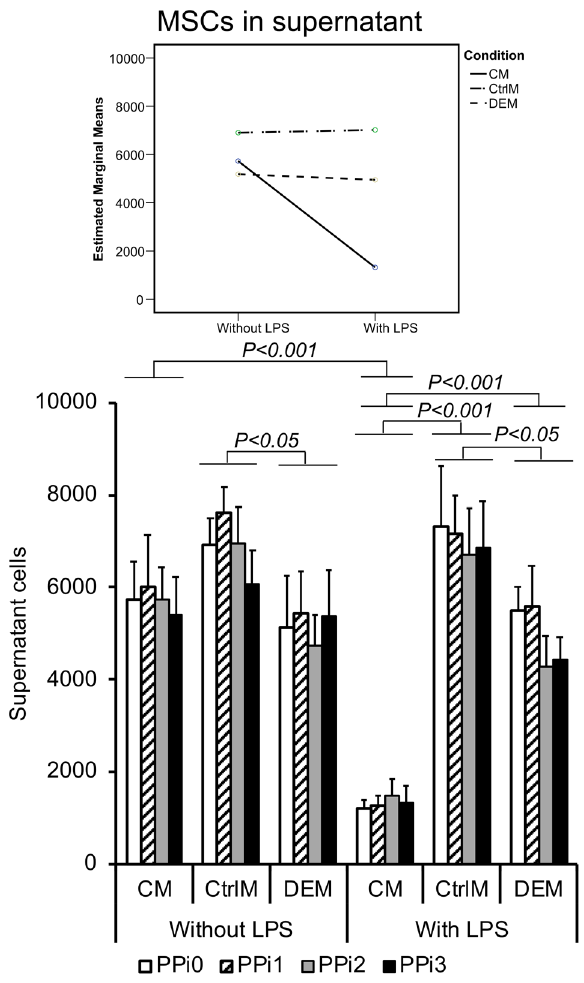
Fig. 3 Cell count of mesenchymal stem cells (MSCs). Number of MSCs in the supernatant after 72 h of culture in different culture media: CM = conditioned media from monocytes incubated for 48 h in polystyrene well plates in the presence or absence of lipopoly- saccharide (LPS) and exposed to different pyrophosphate (PPi) con- centrations; CtrlM = control media incubated for 48 h in polystyrene well plates in the presence or absence of LPS and exposed to different PPi concentrations; DEM = direct effect media incubated for 48 h in 50 mL tubes and used for direct exposure of MSCs to LPS and dif- ferent PPi concentrations. The different PPi concentrations were as follows: 0 μ M (PPi0), 50 μ M (PPi1), 100 μ M (PPi2) and 250 μ M (PPi3). The line graph (top) shows the interaction effect of culture condition and exposure to LPS, whereas the bar graph (bottom) shows the mean and standard error of the mean ( n = 4 – 5). Connected bars indicate signi fi cant differences ( P < 0.05; P < 0.001) between LPS and non-LPS as well as between the different conditions (CM, CtrlM,